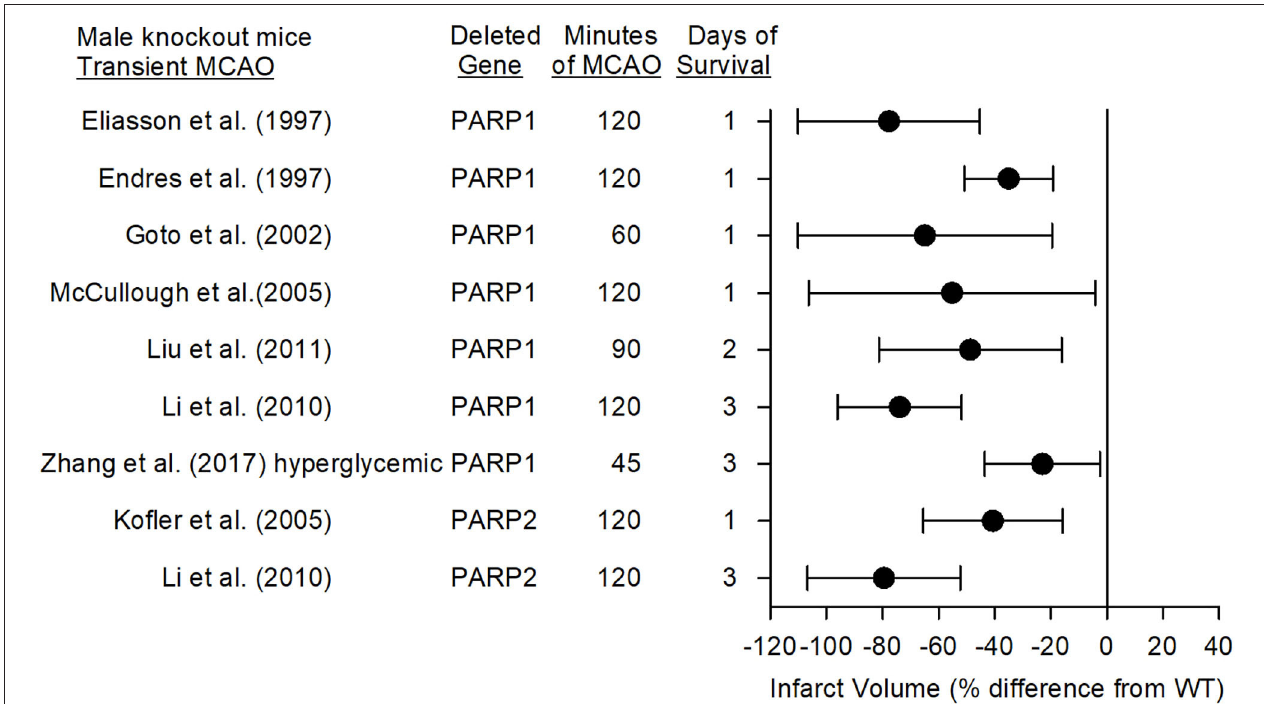
FIGURE 3 | Effect sizes and 95% confidence intervals on infarct volume after transient middle cerebral artery occlusion (MCAO) in male PARP1 − / − mice and male PARP2 − / − mice, relative to their respective wild-type controls, were derived from mean and SD values and sample sizes extracted from publications by Eliasson et al. (27), Endres et al. (68), Goto et al. (69), McCullough et al. (70), Liu et al. (71), Li et al. (72), Zhang et al. (73), and Kofler et al. (74). These reports from three different laboratories showed significant reductions in infarct